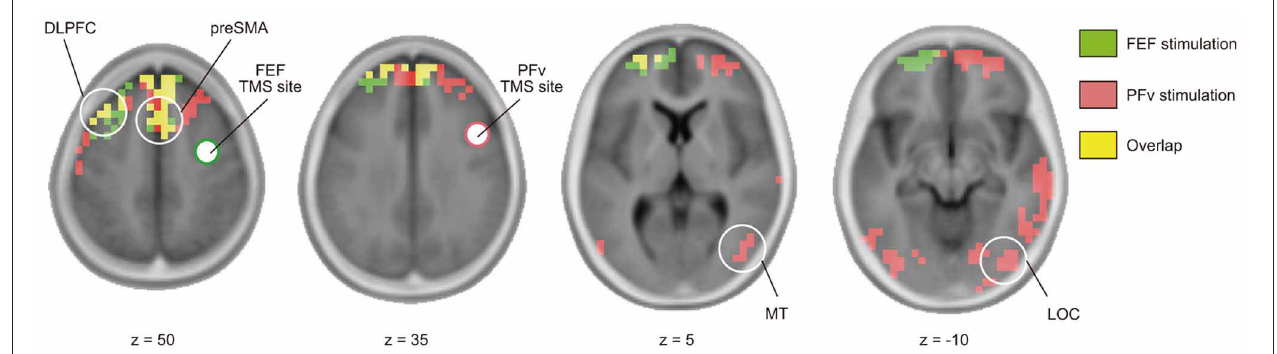
FIGURE 4 | Effective connectivity based on TMS-EEG. Distribution of cortical source density estimated from TMS-evoked potentials during 20–40ms after stimulation of FEF (green) and PFv (red) (threshold: p < 0.05,